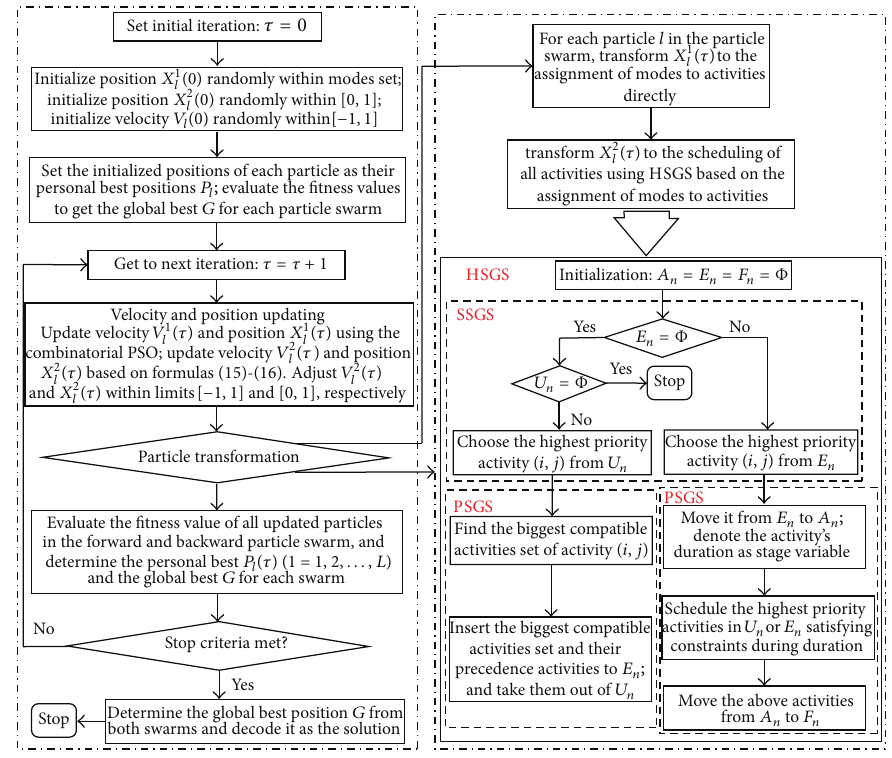
Figure 4: Overall procedure of the CP-based HPSO